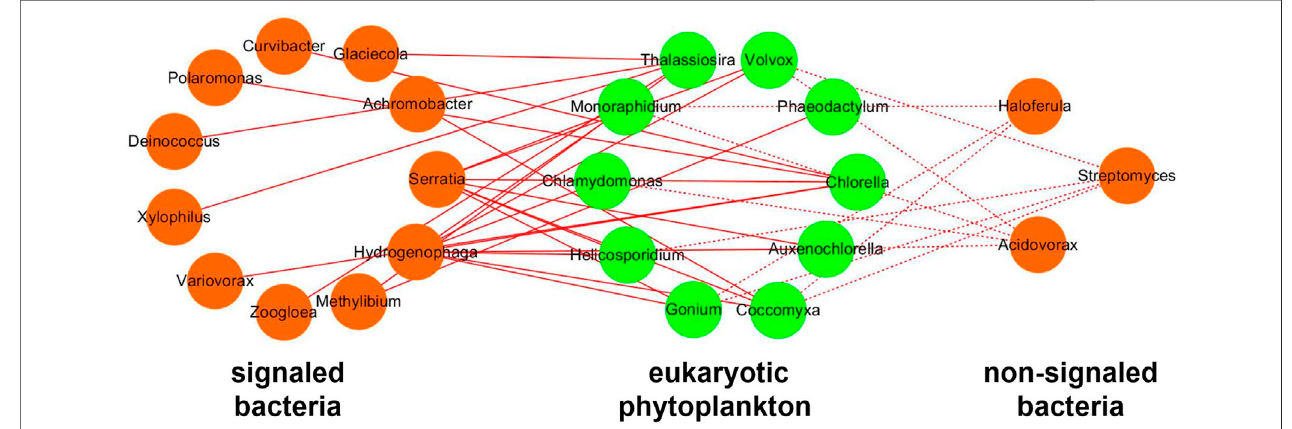
FIGURE 10 | Network of positive correlation between bacteria and eukaryotic phytoplankton. Orange nodes represent bacteria, and green nodes represent phytoplankton. Solid lines represent positive correlation between signaled bacteria and phytoplankton, and dotted lines represent positive correlation between non- signaled bacteria and